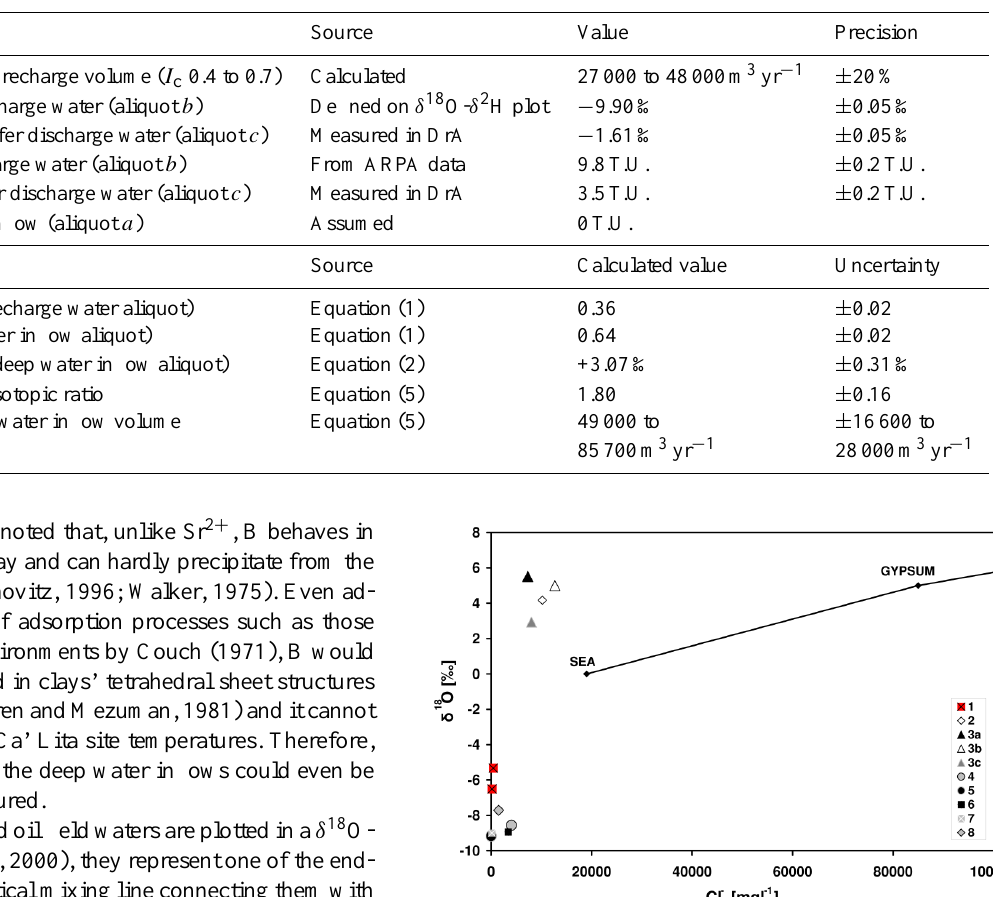
Table 5. Relevant data and results of isotopic groundwater balance at the landslide slope scale. Precision of measured values is that of the an- alytical determination methods. Uncertainties in calculated values are assessed using error propagation methods presented by Taylor (1997). Rainfall recharge volume ( V r ) is calculated with the Thornthwaite and Mather (1957) formula by using infiltration coefficient ( I c ) ranging from 0.4 to 0.7. The uncertainty related to V r is considered equal to ± 20–25% by Fetter (2001), mostly due to the quality of the original rain- fall and temperature datasets. As the quality level of the adopted ARPA dataset could not be assessed specifically in this study, an indicative value of ± 20% is given.